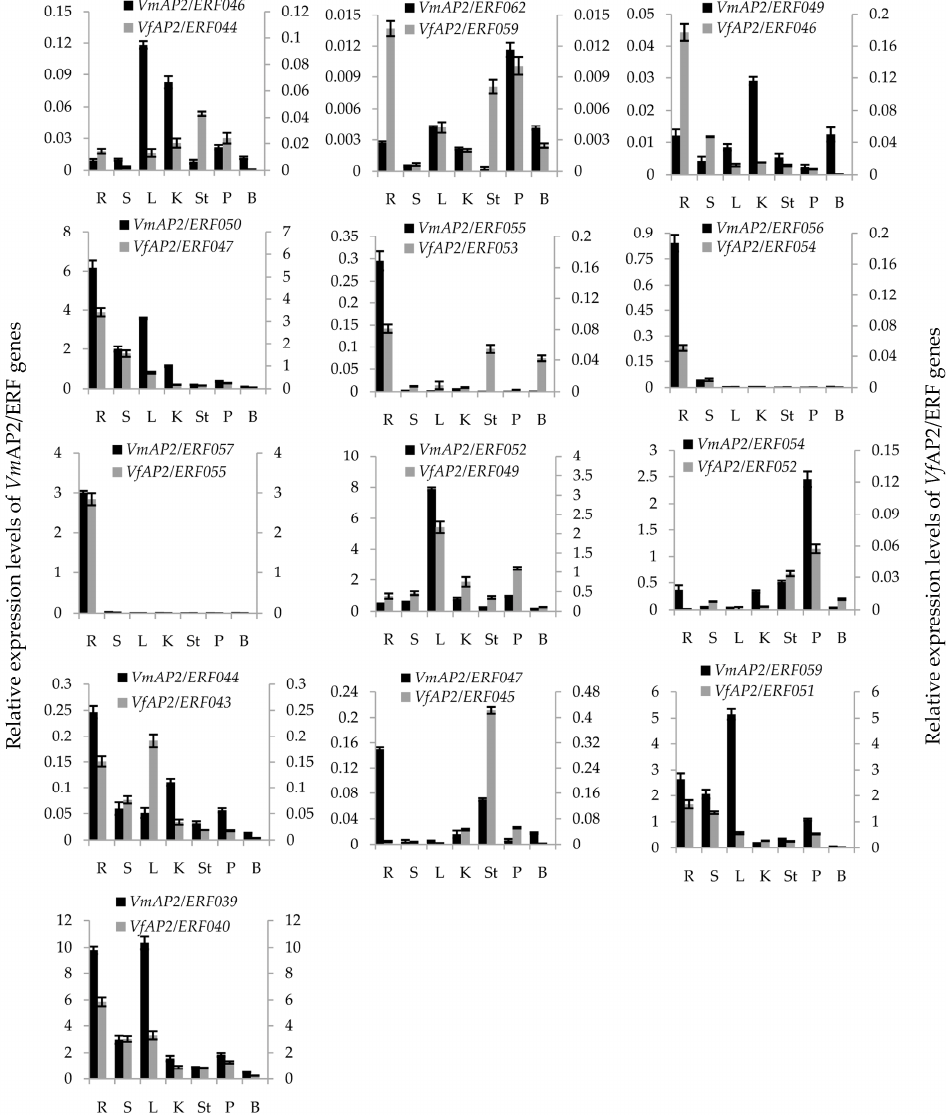
Figure 6. Tissue specific expression analyses of 26 Vf / VmAP2 / ERF genes in Vernicia . Root (R), stem (S), leaf (L), kernel (K), stamen (St), petal (P) and bud (B) tissues were used for the expression analysis. The y -axis represents relative expression level. Primary y -axis indicates transcript levels of VmAP2/ERFs ; secondary y -axis indicates transcript levels of VfAP2/ERFs . Expression level was analyzed using qRT-PCR in triplicate.